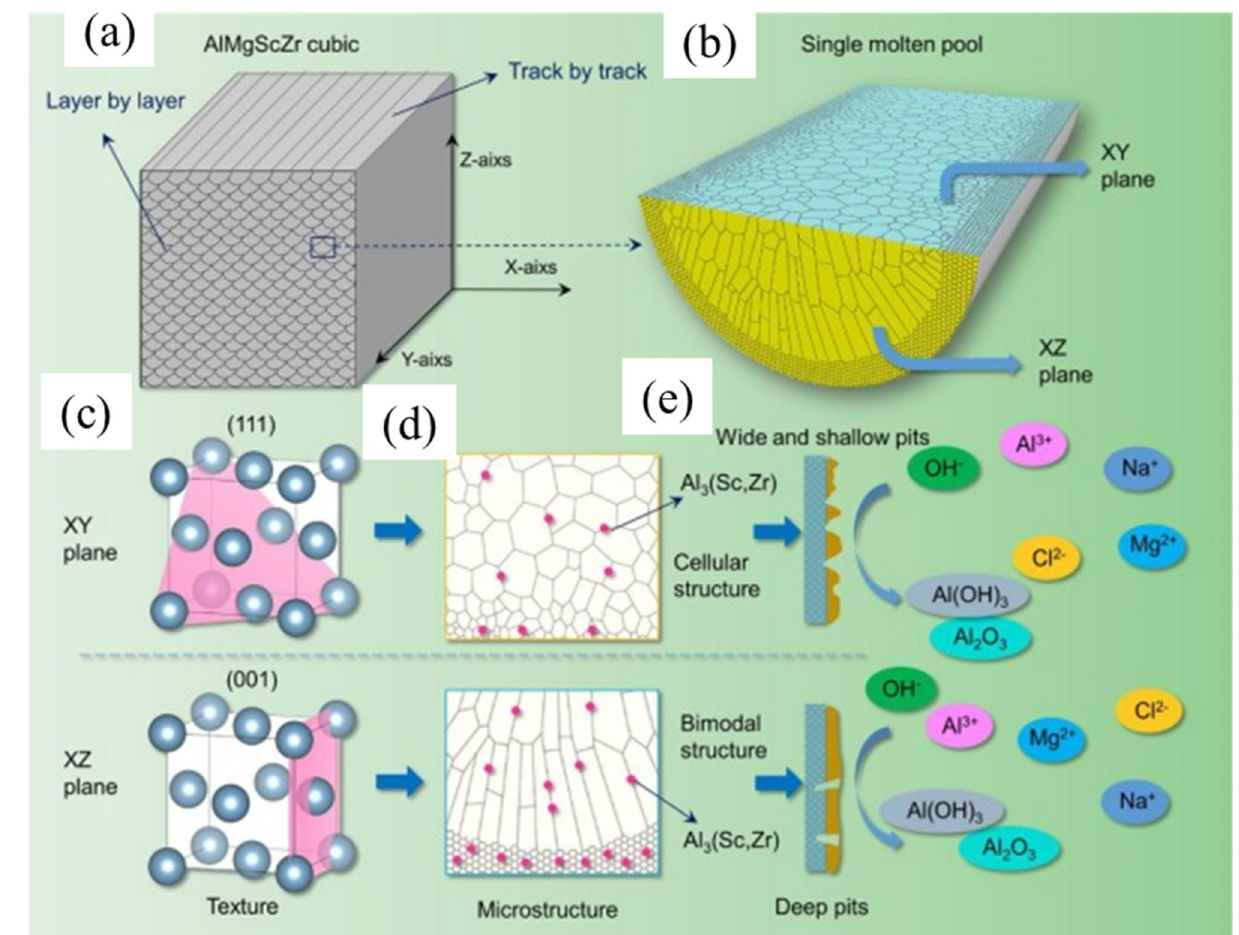
Figure 9. Schematic of different microstructures and corrosion mechanisms on XY and XZ planes of Al-Mg-Sc-Zr alloy fabricated using selective laser melting: ( a ) melt pool boundary densities on XY and XZ planes; ( b ) distribution of grain size in a single melt pool; ( c ) preferred crystallographic orientations on XY ( top ) and XZ ( bottom ) plane; ( d ) Al 3 (Sc,Zr) precipitation distributions on XY ( top ) and XZ ( bottom ) planes; ( e ) corrosion mechanisms on XY ( top ) and XZ ( bottom ) planes. Reprinted with permission from ref. [317]. Copyright 2021